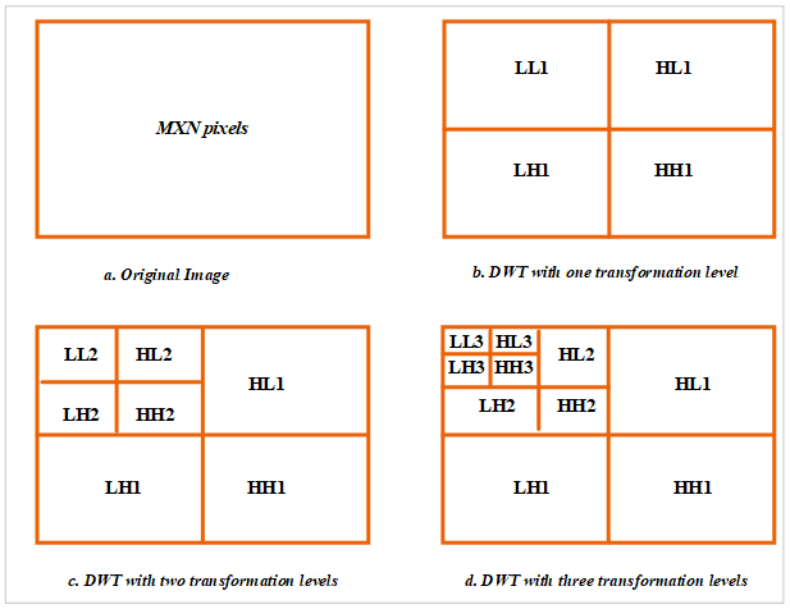
Figure 1. One-layer, two-layer and three-layer decomposition of